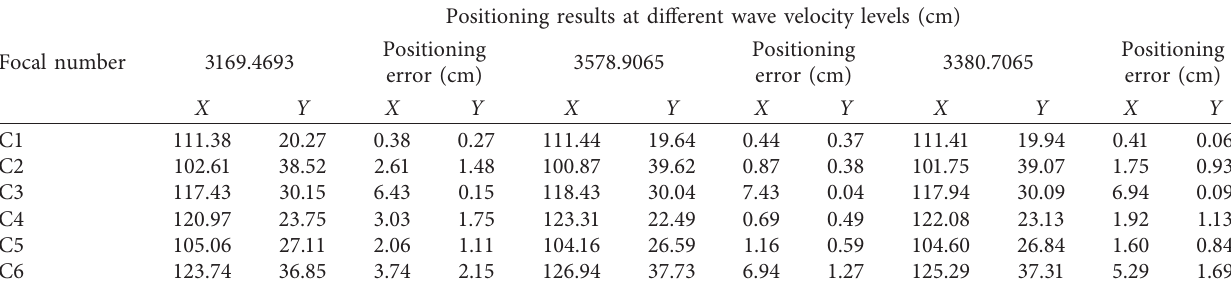
Table 17: Source location results for Scheme II of